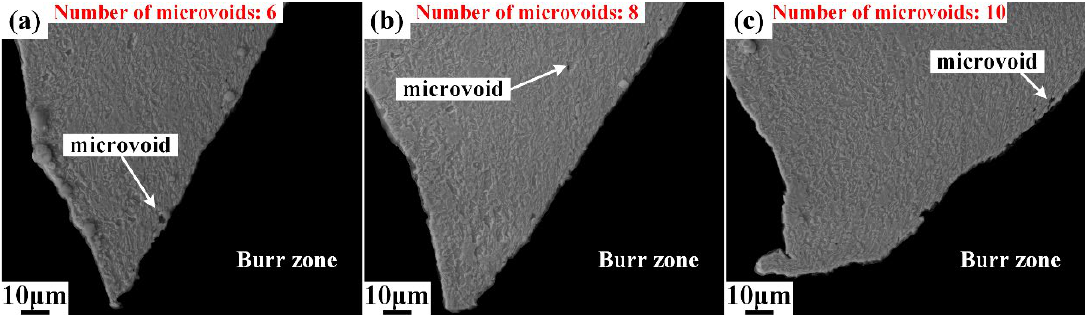
Figure 14. Microstructure of sheared edge in Area VI obtained under different shearing clearances: